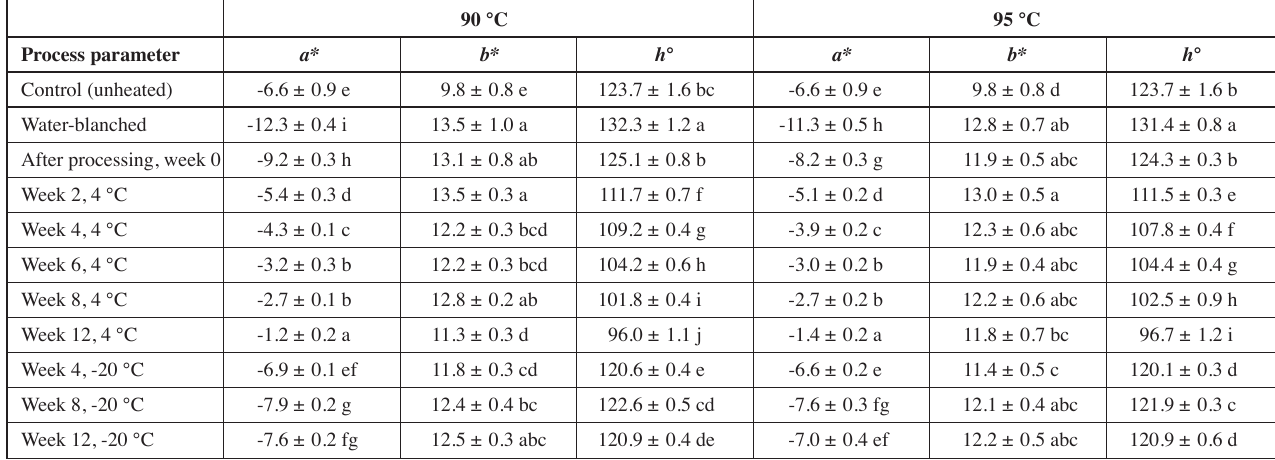
Tab. 2: Color characteristics during processing (90 and 95 °C) and storage (12 weeks at 4 and -20 °C) of pasty celeriac products (n = 6)